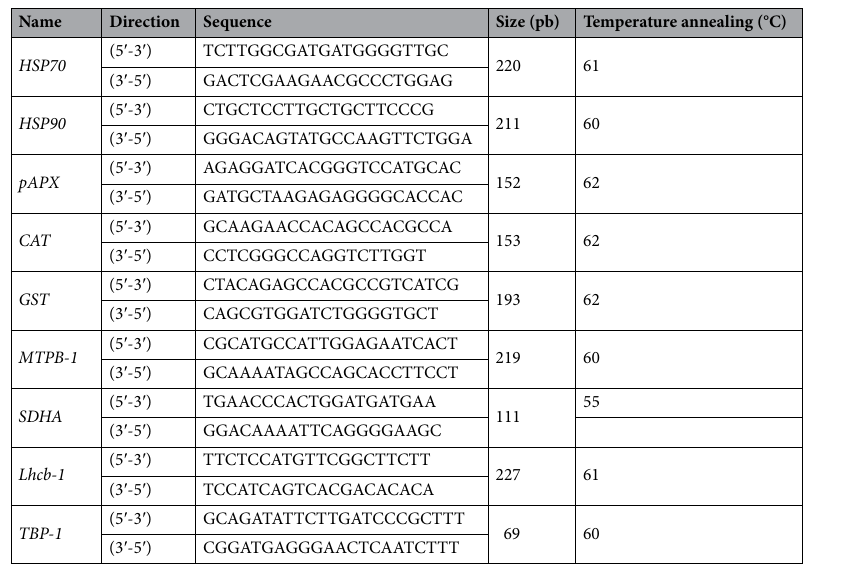
Table 1. Information of selected